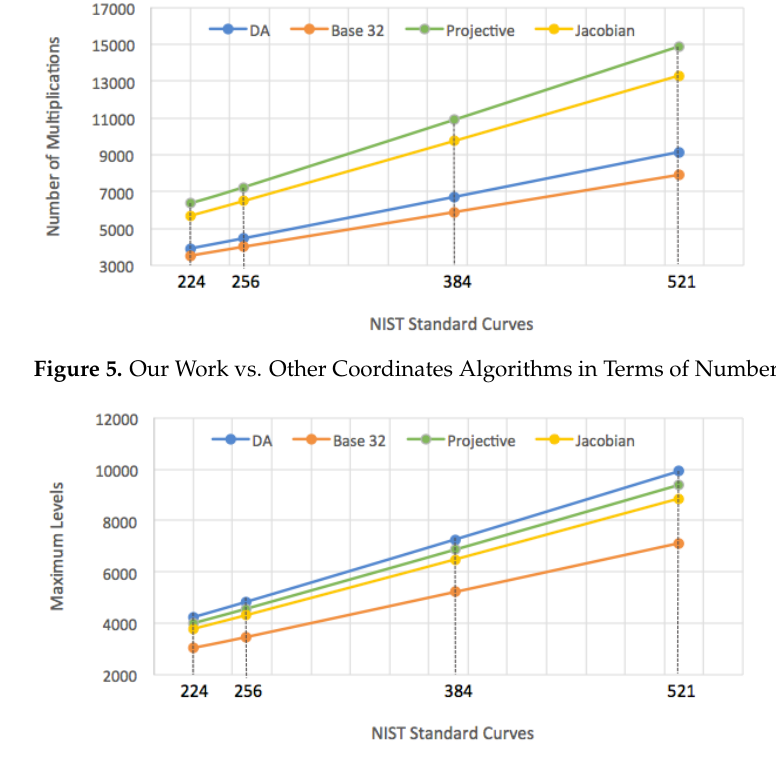
Figure 6. Our Work vs. Other Coordinates Algorithms in Terms of Number of Maximum Number of Levels.